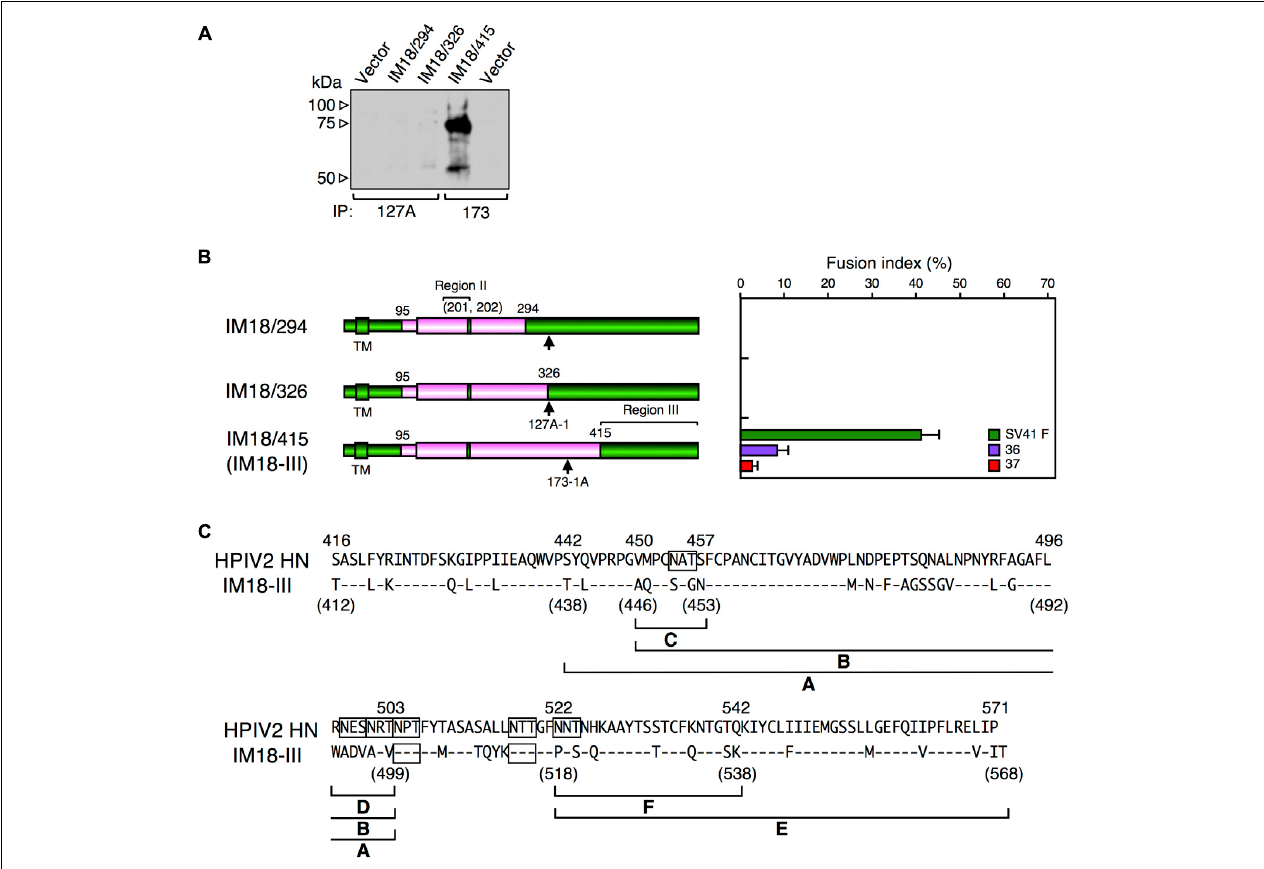
FIGURE 5 | Combination of the SV41 HN-derived region III with specified SV41 HN-derived amino acids in the Region II is important for exhibiting the SV41 HN-like F protein specificity. (A) Detection of cell surface-localized HN proteins. The cell surface-localized HN proteins were detected as described in the legend for Figures 4A,B . Vector: pcDL-SR α expression vector used as the negative control. (B) F protein specificity of the HN proteins. The average fusion index was determined at 24 h post transfection as described in the legend for Figure 3D ; error bars indicate standard deviation. The residue numbers of SV41 HN-derived amino acids in the region II was indicated in the parenthesis. The representative data of more than three independent experiments are shown. The fusion indices are not normalized to the cell surface-localization levels which could not be determined due to the use two detection antibodies. (C) Amino acid sequence alignment